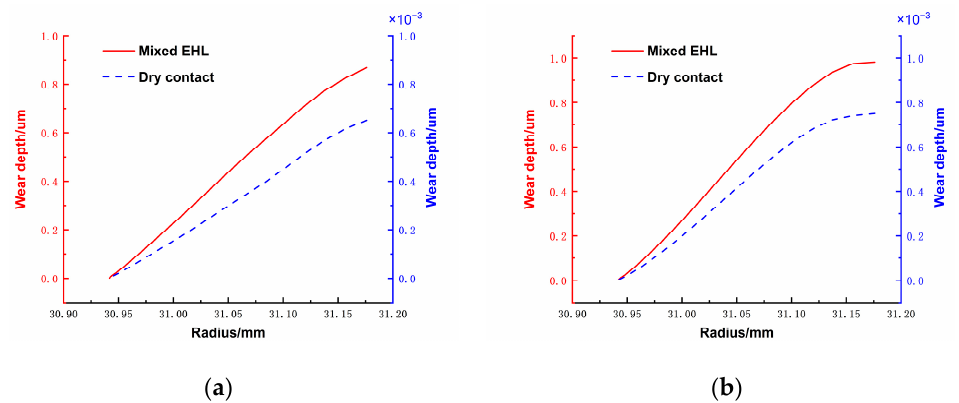
Figure 13. Wear depth along the radius for mixed EHL and dry contact: ( a ) double-arc tooth profile; ( b ) involute tooth profile. ( b ) involute tooth